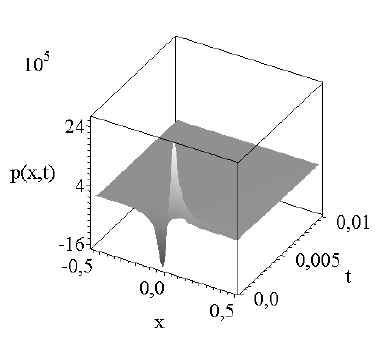
Figure 4. The final pressure distribution of (2.6) p = 1 h (cid:0) x/t 0 . 5 (cid:1) for the parameter set t 1 of c 4 = 0 . 2 ,c 5 = 0 ,a = 0 . 27 ,ν = 40 ,ρ 1 = 2 ,ρ 2 = 20. Note, that the pressure in (2.6) is defined up to a constant value. If one wants to avoid negative pressures, then an appropriate constant pressure should be added to the values presented